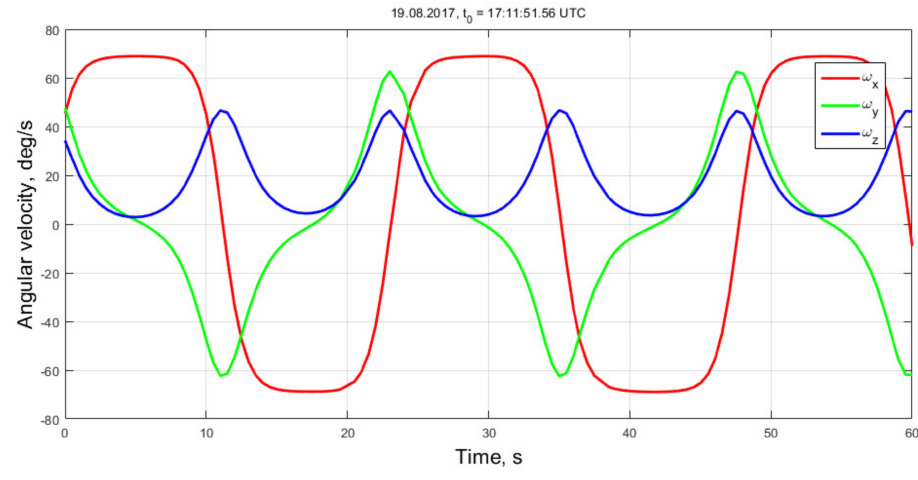
Figure 6. Angular velocity components.